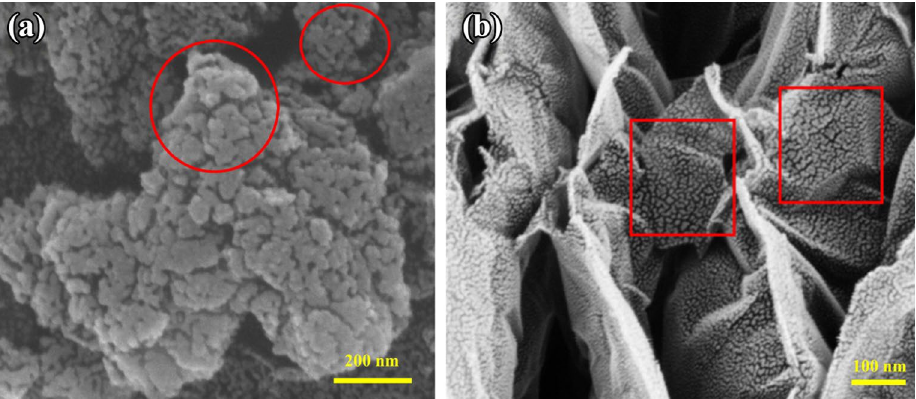
Figure 4. FESEM images of synthesized materials, ( a ) PC, ( b )